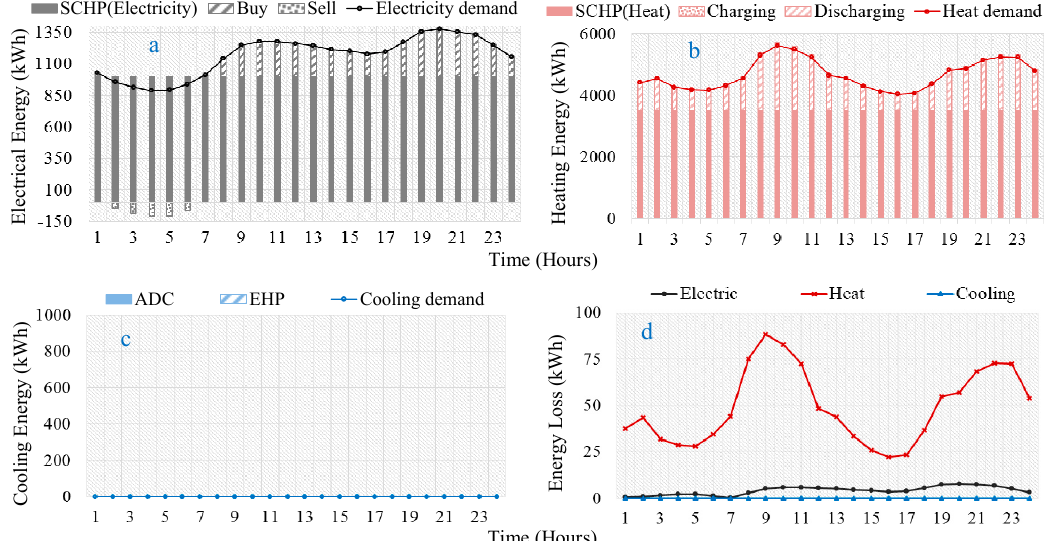
Figure 10. Energy balancing of BMG1 in winter season: ( a ) electrical energy; ( b ) heating energy; ( c ) cooling energy; and ( d ) energy loss.